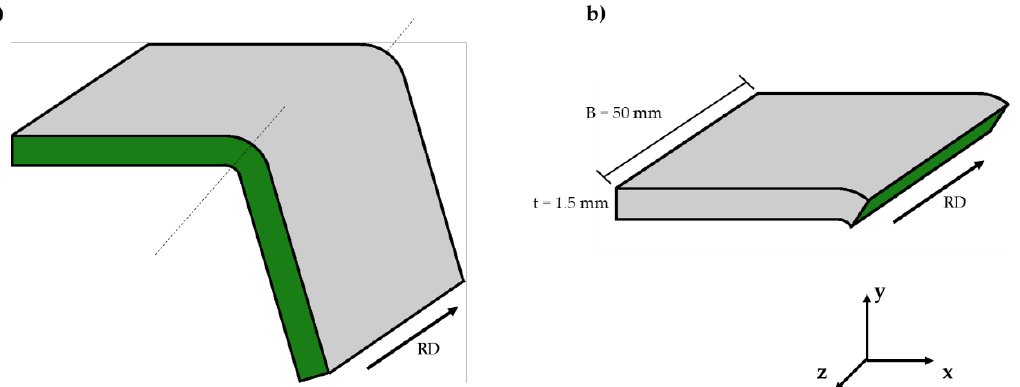
Figure 5. Evaluated planes in the bending samples (illustration): ( a ) cutting plane parallel to the bending plane (“in-plane”, x – y plane); ( b ) cutting plane parallel to the bending axis (“cross-section”, y – z plane). RD represents the rolling direction of the sheet.